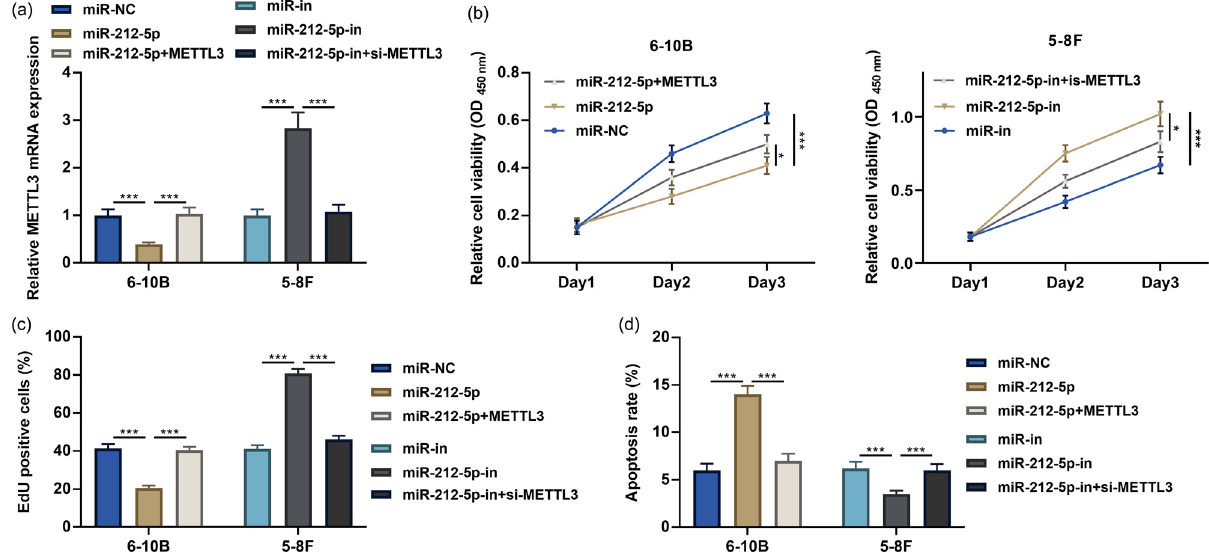
Figure 4: miR - 212 - 5p regulates the proliferation and apoptosis of NPC cells by targeting METTL3. ( a ) miR - 212 - 5p mimics and METTL3 overexpression plasmids were co - transfected into 6 - 10B cells, and miR - 212 - 5p - in and si - METTL3 were co - transfected into 5 - 8F cells. The expression of METTL3 mRNA was detected by qRT - PCR. ( b and c ) After transfection, the cell proliferation was assessed by the CCK - 8 assay and EdU assay. ( d ) After transfection, the cell apoptosis was assessed by fl ow cytometry. *P < 0.05, **P < 0.01, and ***P <